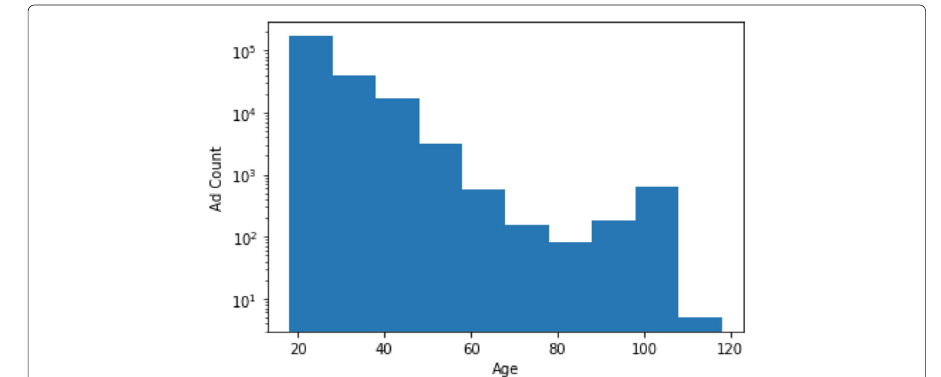
Fig. 3 A distribution of ads with non-zero